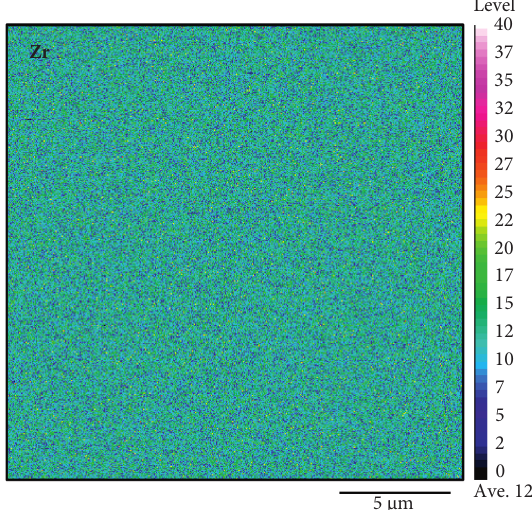
Figure 3: EPMA analysis of surface of zirconia sensor. Zr: